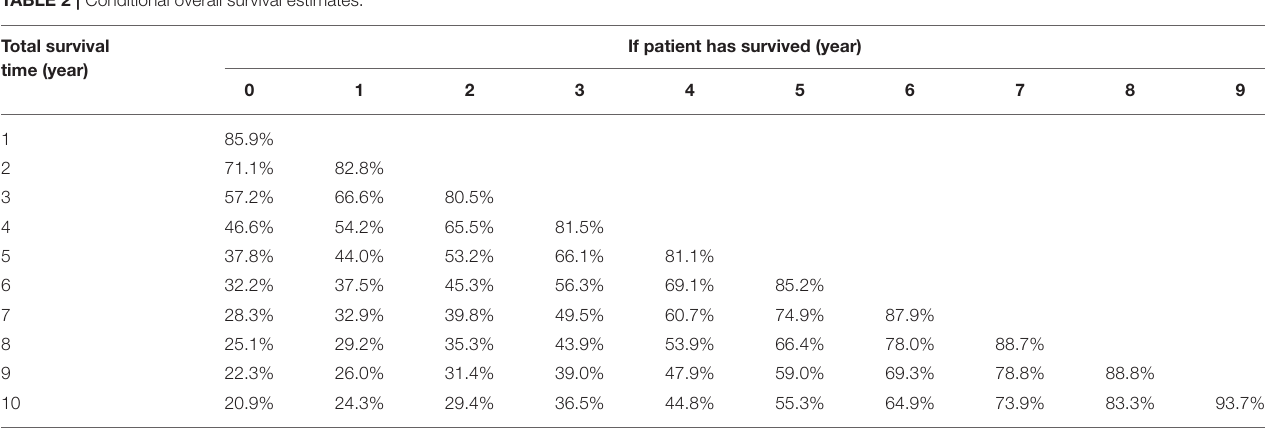
TABLE 2 | Conditional overall survival